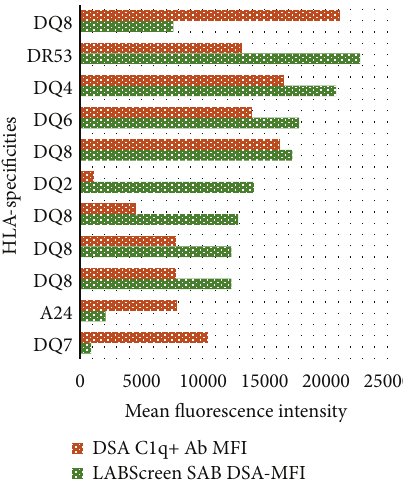
Figure 1: Comparison of the DSA LABScreen SAB MFI and DSA C1q+ Ab in studied patients and HLA antigenic